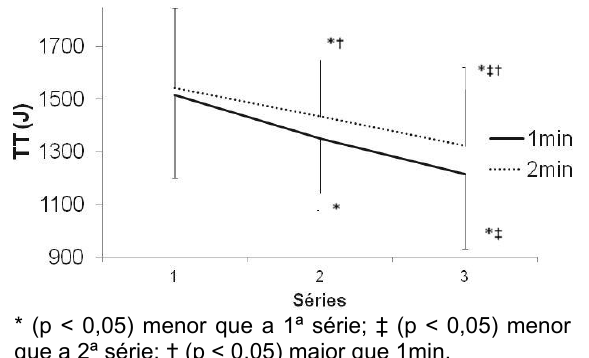
Figura 3. Trabalho Total (TT) a 60°/s nas três séries com 1 e 2min de intervalo de recuperação. A Figura 4 ilustra o TT realizado a 180°/s com 1 e 2min de IR. Observou-se uma redução no TT de 5,6% da 1ª para 3ª série (p = 0,001) e de 3,9% da 2ª para 3ª série (p = 0,001) com 1min de IR. Não houve diminuição significante (p > 0,05) do TT ao longo das três séries com IR de 2min. O intervalo de 2min possibilitou um maior valor do TT, quando comparado a 1min, apenas na 3ª série (p = 0,005) no gênero feminino.